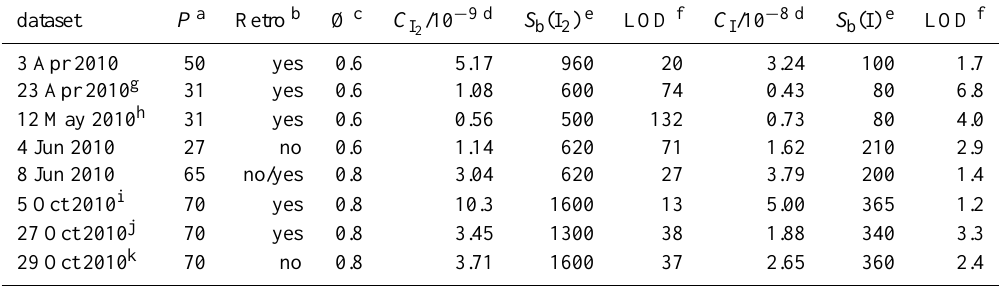
Table 3. Summary of typical calibration conditions and results.